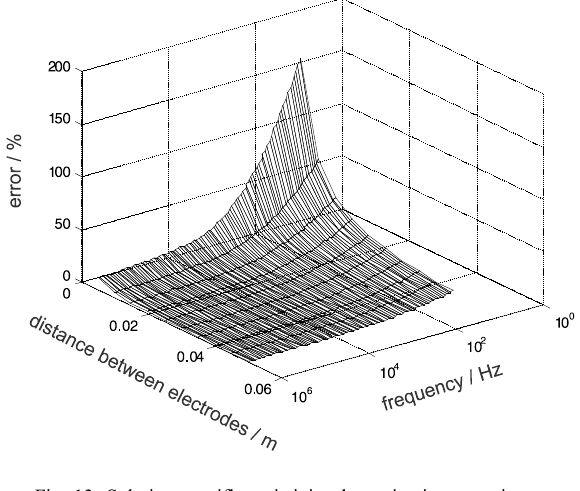
Fig. 13: Solution specific resistivity determination error in case the double layer is not taken into account. Frequency range is from 20 Hz to 1 MHz, the distance between the electrodes is from 5 to 45